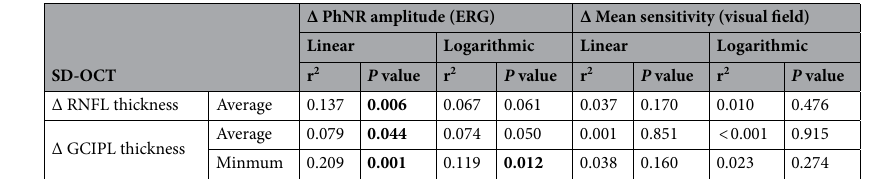
Table 6. The relationship between ΔRNFL or ΔGCIPL thickness and Δ photopic negative response (PhNR) amplitude or Δ mean sensitivity of standard automated perimetry between better and worse eyes. GCIPL, Ganglion cell-inner plexiform layer; PhNR, photopic negative response; RNFL, retinal nerve fiber layer. Statistically significant values ( P < 0.05) are in bold.